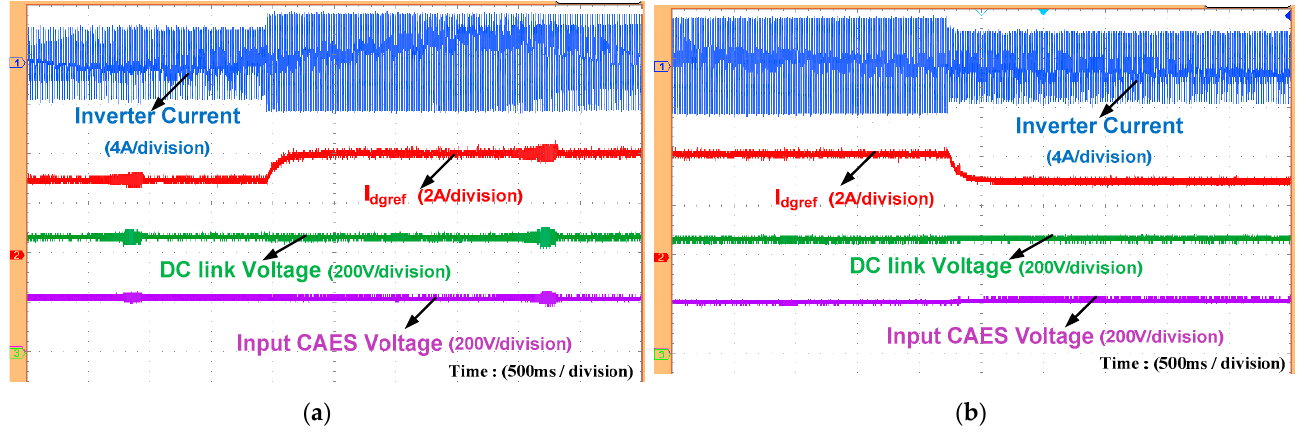
Figure 15. ( a ) Inverter current for rise in Idgref, ( b ) inverter current for fall in Idgref.